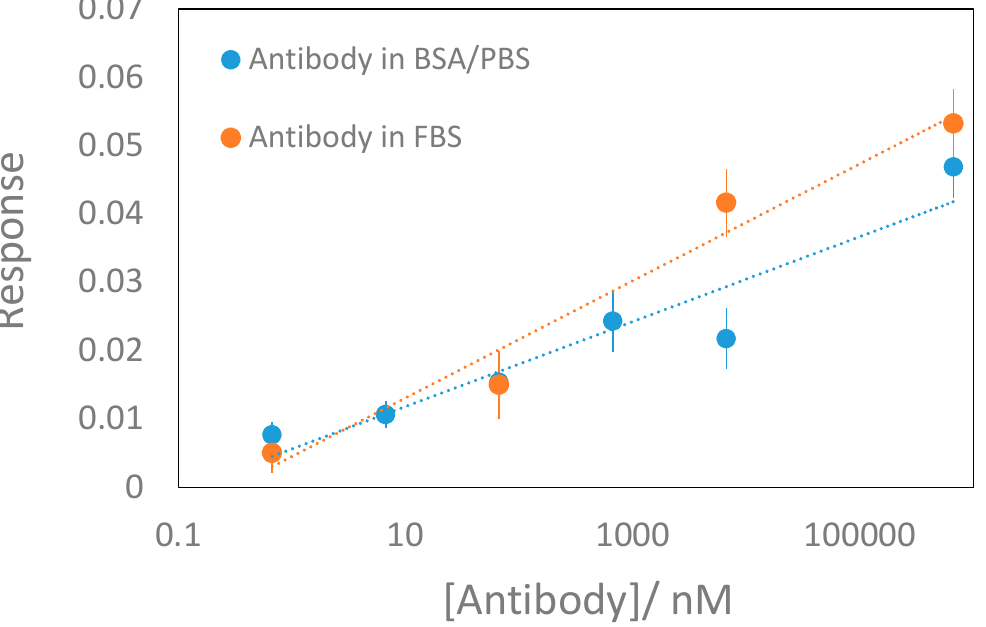
Figure 5. Calibration curves for the response function of the severe acute respiratory syndrome coronavirus 2 (SARS-CoV-2) antibodies in PBS diluted in aqueous BSA solution (blue points and curve) and in FBS (orange points and orange curve).